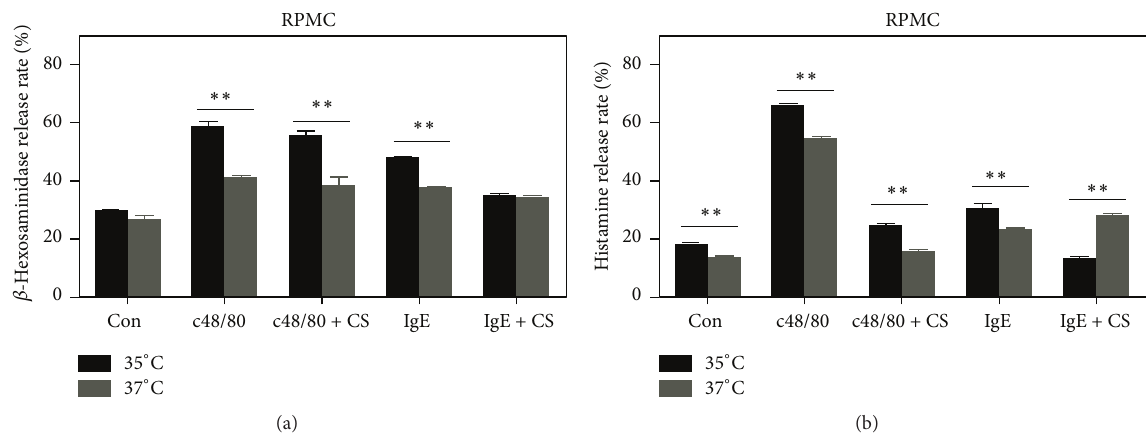
Figure 4: The effect of temperature on rat peritoneal mast cell degranulation. Rat peritoneal mast cells (RPMC) were left untreated (Con) or treated by either c48/80 or a combination of IgE and anti-IgE (IgE). In some experiments, cells were activated in the presence of the mast cell stabilizer cromolyn sodium (CS). 𝛽 -Hexosaminidase (a) and histamine (b) release was measured. 𝛽 -Hexosaminidase or histamine release is expressed as percent of the total (the means ± SE, 𝑛 = 4 , representing at least three separate experiments). ∗∗ 𝑃 < 0.01 .